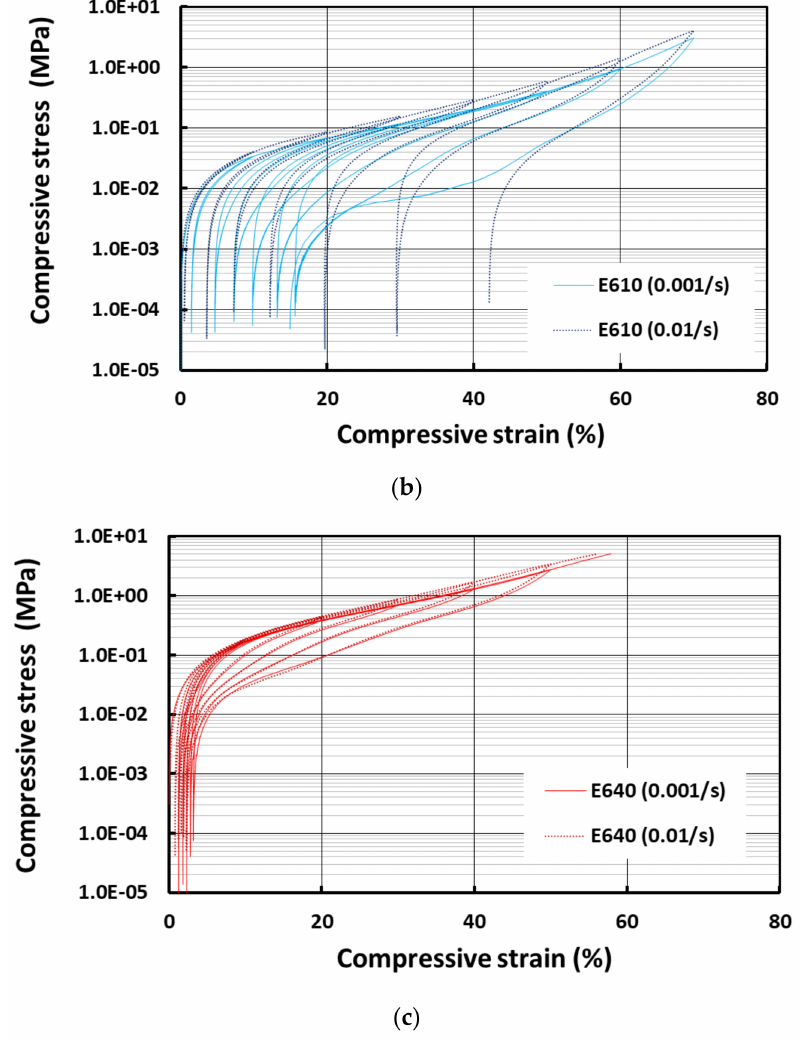
Figure 7. Influence of strain rate in cyclic uniaxial compression of pure silicones (E610 and E640). ( a ) Stress vs. strain curves at two different strain rates of 10 − 2 /s and 10 − 3 /s; ( b ) logarithmic plot of stress for E610; ( c ) logarithmic plot of stress for